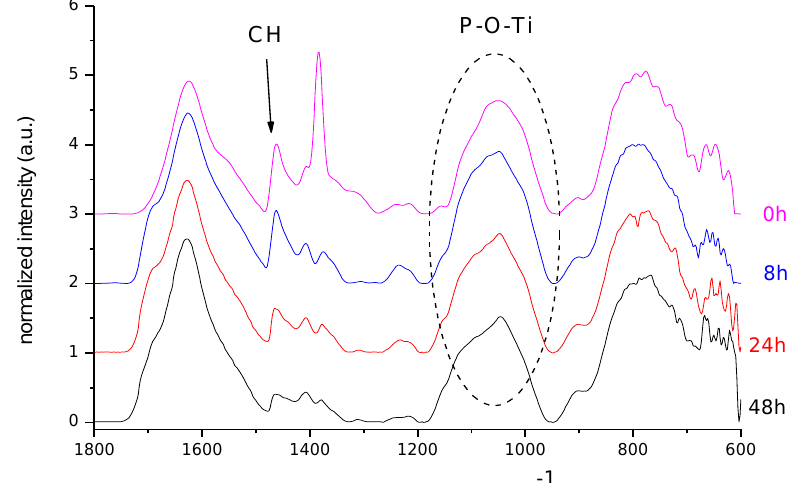
Figure 16. FT-IR spectra (KBr: 2mg sample, 150 mg KBr) of DPA @ TiO times of